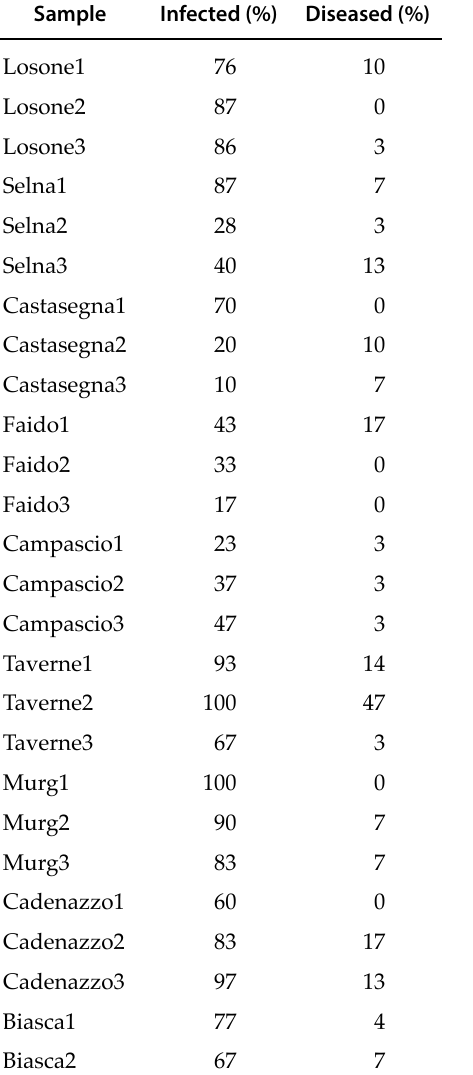
Table 5. Percent of infected and diseased nuts for each sam-